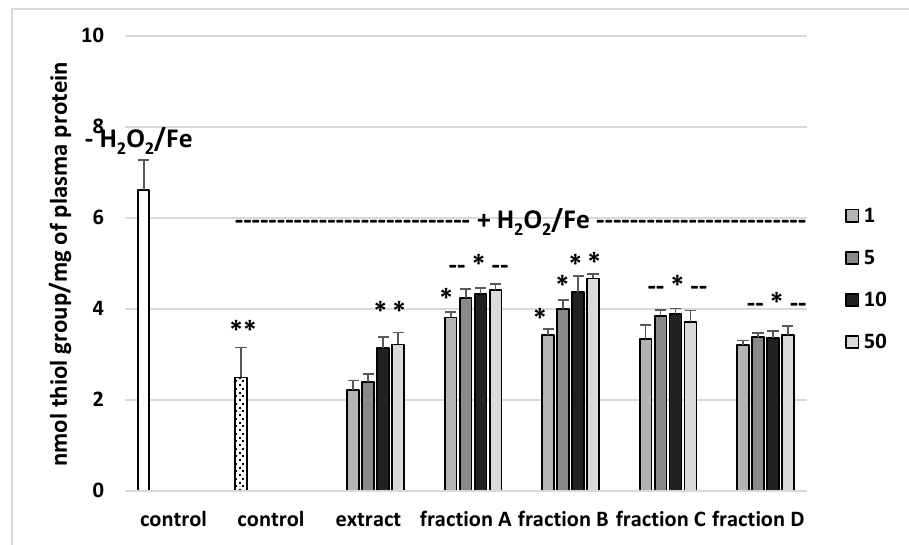
Figure 4. Effects of the extract and the four fractions (A–D, concentration range 1–50 µg/mL, pre-incubation time—5 min) from Paulownia Clone in Vitro 112 leaves on the oxidative damages of plasma protein treated with H 2 O 2 /Fe (incubation time—25 min)-the level of thiol groups. Results are given as mean ± SEM ( n = 6). Control negative (white bar) refers to plasma not treated with H 2 O 2 /Fe, whereas control positive (black bar) to plasma treated with H 2 O 2 /Fe. One-way ANOVA followed by a multicomparison Duncan′s test: -- p > 0.05, * p ≤ 0.05, ** p ≤ 0.02, compared with positive control (treated with H 2 O 2 /Fe).